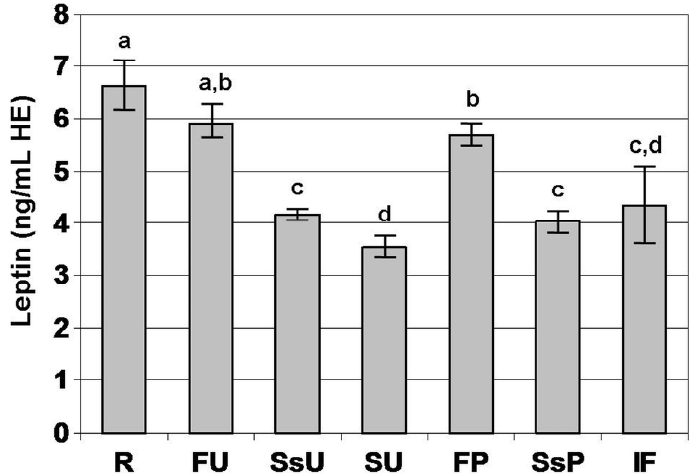
(Figure 3), but it was not correlated with protein ( r = − 0.125, n = 60, p > 0.10) and carbohydrate content ( r = − 0.044, n = 60, p > 0.10). Figure 1. Mean levels of leptin in raw milk (R), full-cream UHT milk (FU), semi-skimmed UHT milk (SsU), skimmed UHT milk (SU), full-cream pasteurized milk (FP), semi-skimmed pasteurized milk (SsP) and infant formula (IF). Data are expressed as human equivalent (HE). Bars indicate SD. Histograms having unlike superscripts are statistically different.